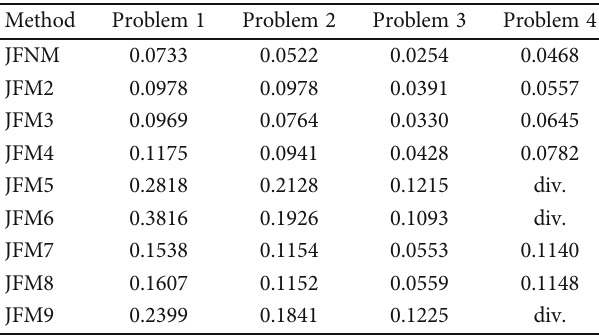
Table 6: Values of JFC2 for case n = 25